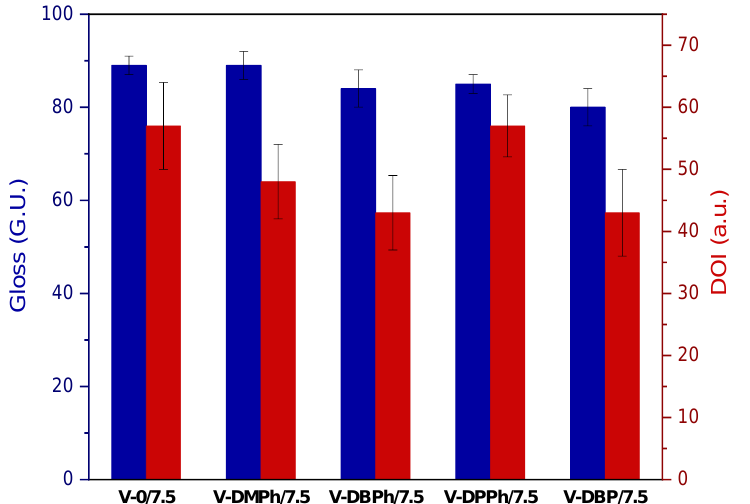
Figure 7. The values of gloss at 20° and DOI parameter of UV-cured varnish coatings containing crosslinking monomer.